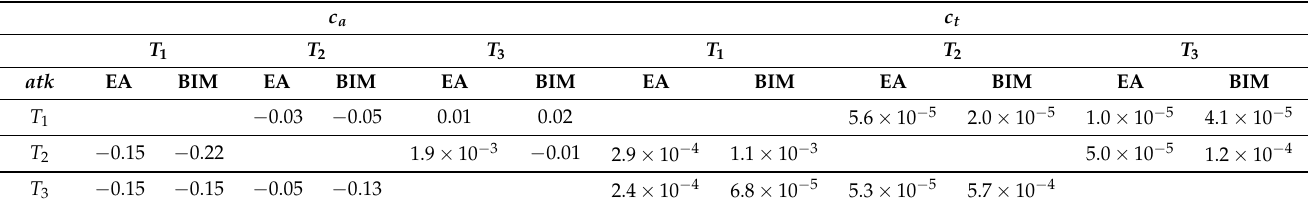
( A p ) and the ancestor A p q q . T t